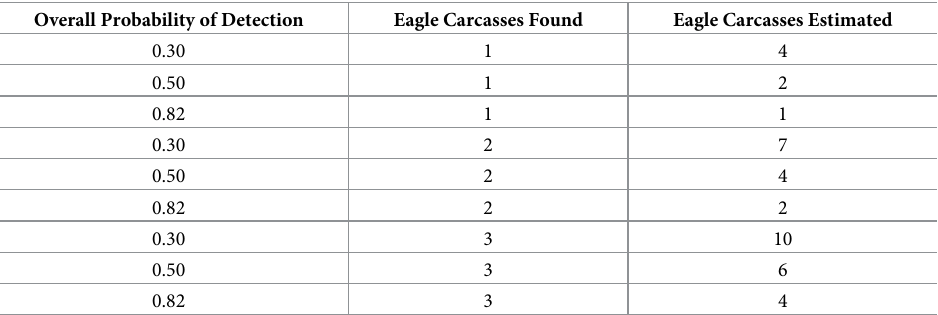
Even if searchers conduct transect searches at all turbines at a facility, the overall probability of detection might still be similar to those found in our study because carcass density distribution and carcass persistence are independent of search type, and searcher efficiency during our scanning searches (50–80%) is comparable to those found during transect-based searches (about 75%) [27, 36]. Researchers can use the overall probability of detection in two ways to evaluate if a facility is within their permitted eagle take or if adaptive management may be needed. First, researchers can use it as a metric to determine “how well” a facility was searched for eagle fatalities attrib- utable to turbine collisions. Although detection probability by itself does not provide action- able information about permit compliance, researchers will find it is an intuitive measure of the efficacy of a monitoring program. Second, the researchers can use the overall probability of detection to adjust the number of eagles found during scanning searches to an estimated Table 12. Evidence of Absence results using a range of overall probability of detection estimates and carcass counts. Higher detection probabilities result in lower take estimates for a fixed carcass count. Overall Probability of Detection Eagle Carcasses